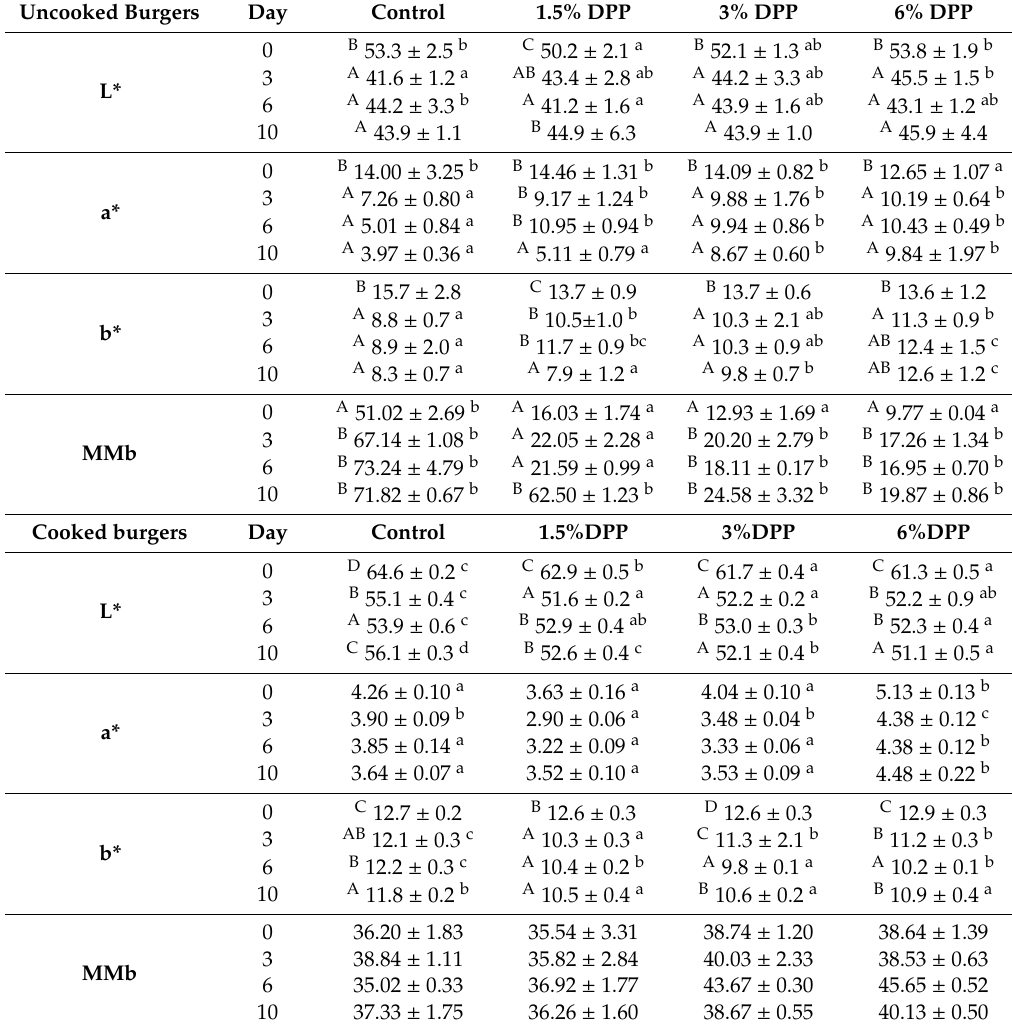
Table 3. Color properties and metmyoglobin percentage (MMb) of burgers (uncooked and cooked) with date pit powder (DPP) during refrigerated